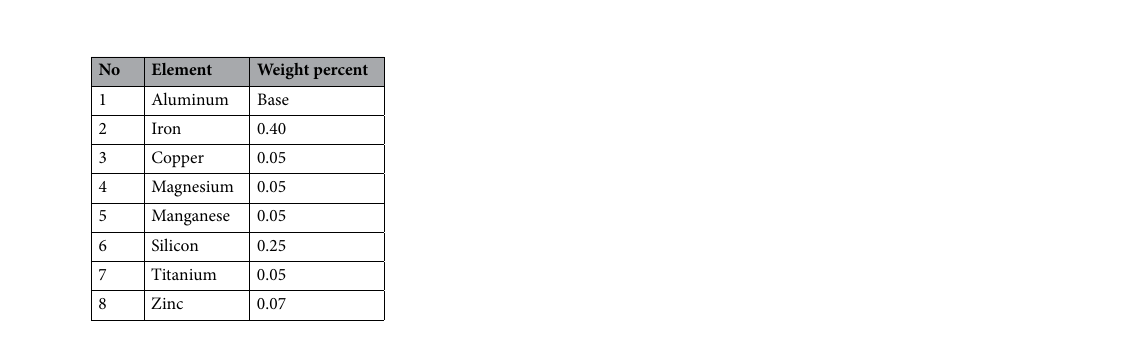
Table 2. Chemical composition of A-H121050 aluminum alloy.